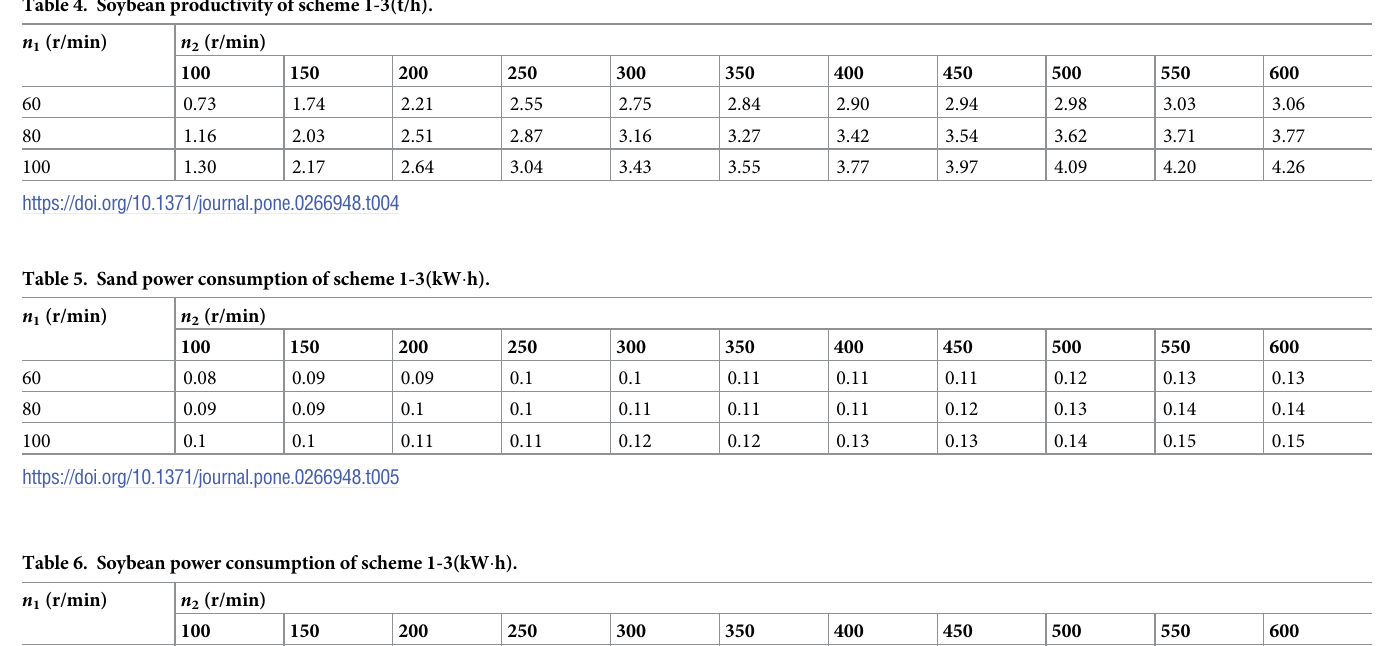
Table 6. Soybean power consumption of scheme 1-3(kW � h).